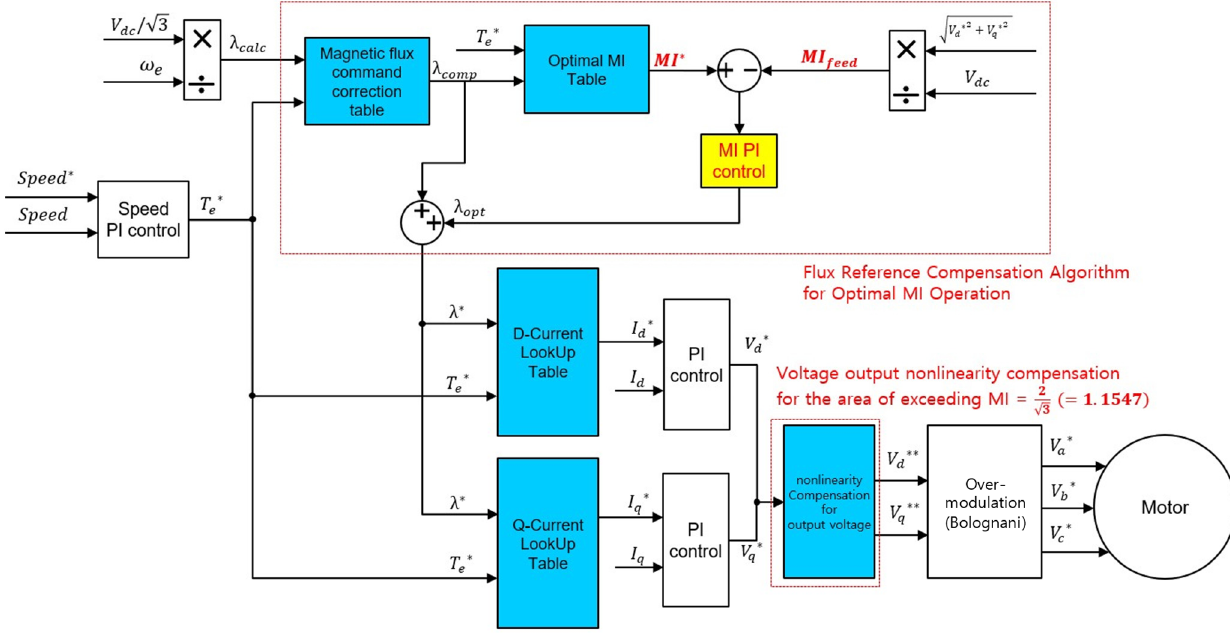
Figure 6. Block diagram of voltage utilization optimal control algorithm.